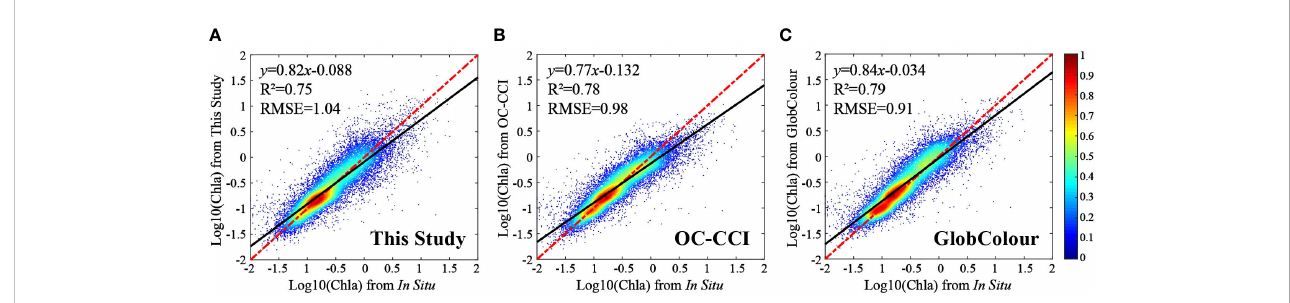
FIGURE 4 Comparison of in situ Chla data with the corresponding 8-day and merged satellite data from (A) this study, (B) OC-CCI, and (C) GlobColour. The color scale indicates the data density in pixels, the black lines are the linear fi tting of in situ and satellite data, and the red dotted lines represent 1:1. Log10 (Chla) was used in the computation of the fi tted equation and R 2 . Chla was used in the computation of RMSE. (Units of Chla: m